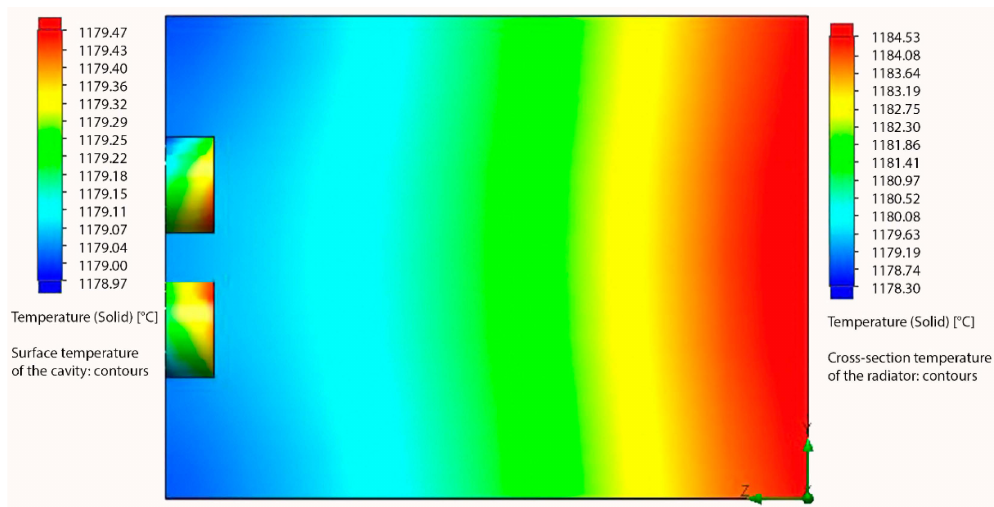
Figure 1. Simulated heating of a tungsten emitter with micro/nanostructure. Adapted from [15] with kind permission from Brno University of